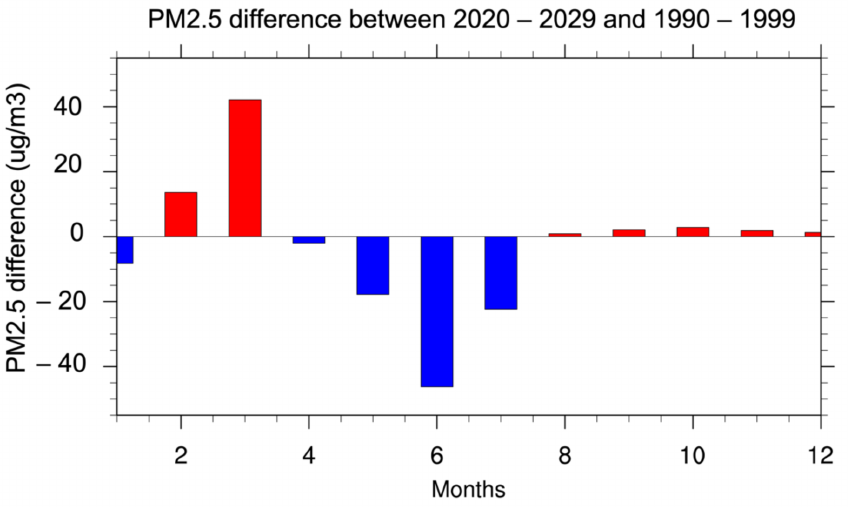
Figure 6. The difference of monthly PM 2.5 concentrations between year 2020–2029 and 1990–1999 over northern Thailand.